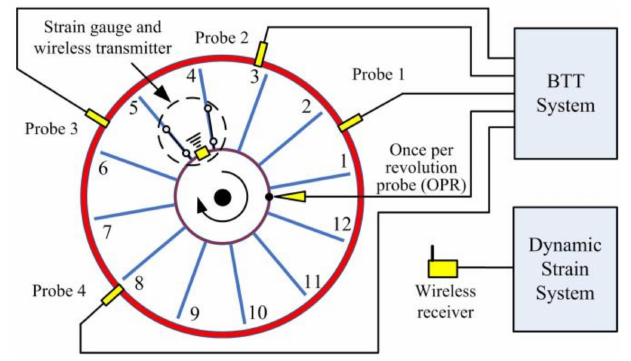
Figure 2. BTT and dynamic strain system diagram.